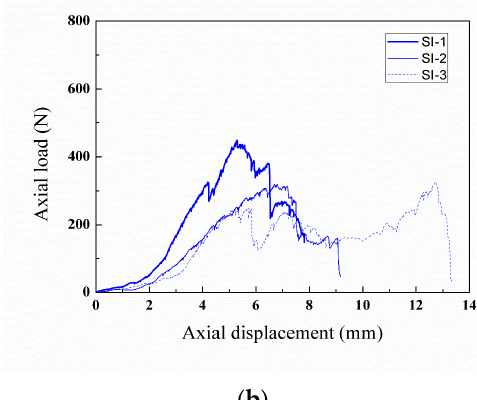
Figure 10. Load–displacement curves for SU and SI under shallow foundation loading: (a) uniform structure; (b) structure with imperfections; (c) selected data for comparison.